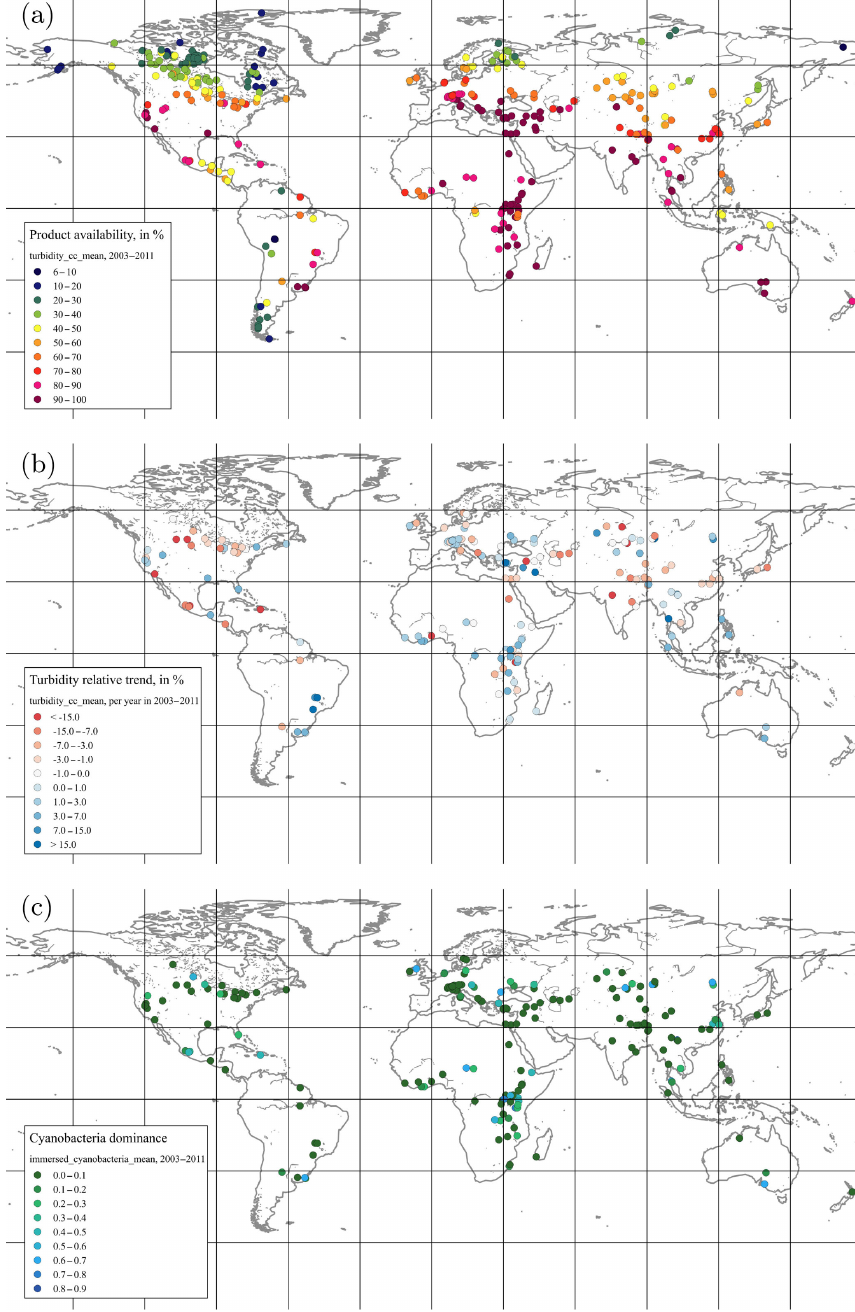
Figure 11. (a) Percentage of the 108 monthly turbidity_cc_mean products with at least 50% coverage of the maximum lake area. (b) Tur- bidity trend, relative to median concentrations, for lakes with at least 50% product availability. (c) Mean cyanobacteria dominance as the average of all spatially averaged monthly immersed_cyanobacteria_mean values for the same